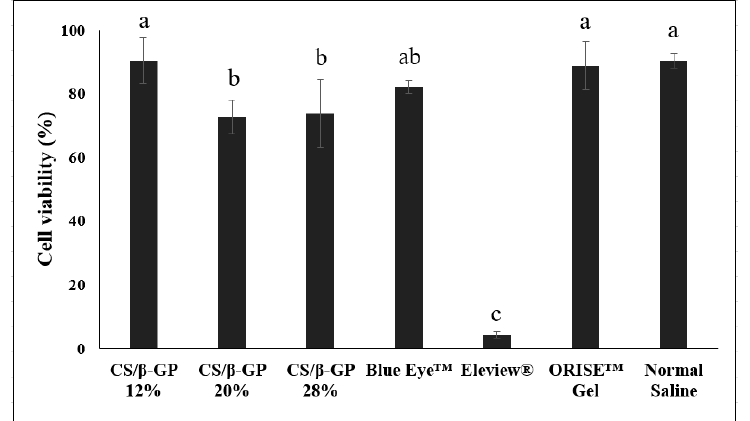
Figure 5. Cytotoxicity of the chitosan thermosensitive solutions (CS/ β -GP 12%, CS/ β -GP 20% and CS/ β -GP 28%) and commercial submucosal injection agents (n = 4, ANOVA, Fisher’s LSD test, p < 0.05). Same letters indicate that there is no statistically significant difference between the samples.